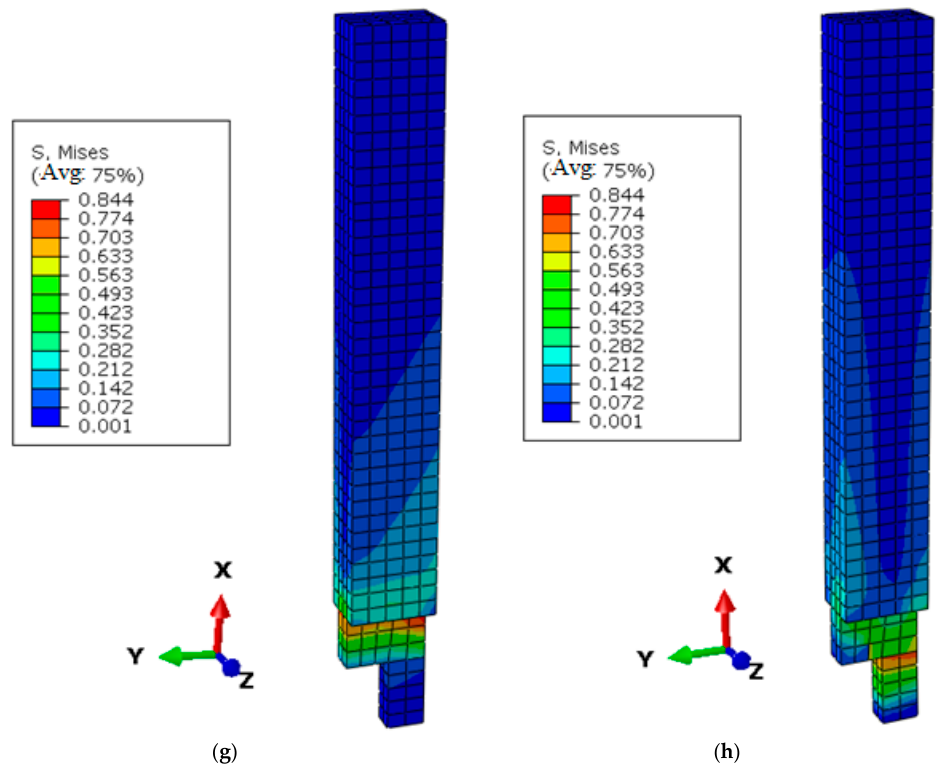
Figure 29. Stress nephogram of loose joints. ( a ) Positive loading of LJ-1. ( b ) Negative loading of LJ-1. ( c ) Positive loading of LJ-2. ( d ) Negative loading of LJ-2. ( e ) Positive loading of LJ-3. ( f ) Negative loading of LJ-3. ( g ) Positive loading of LJ-4. ( h ) Negative loading of LJ-4.